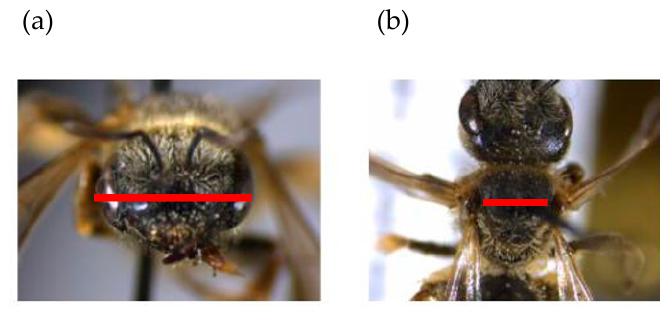
Figure 2. Sample measurement of ( a ) head width and ( b ) intertegular distance of a female H. ligatus.